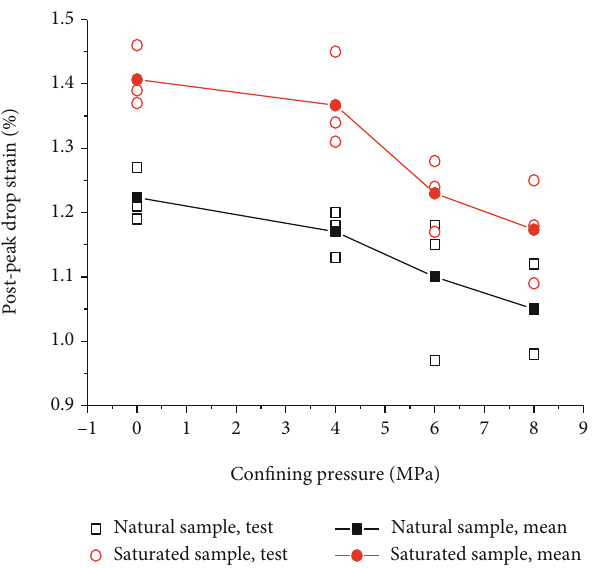
Figure 7: The relationship between elastic modulus and con fi ning pressure of natural and fully saturated rock samples.